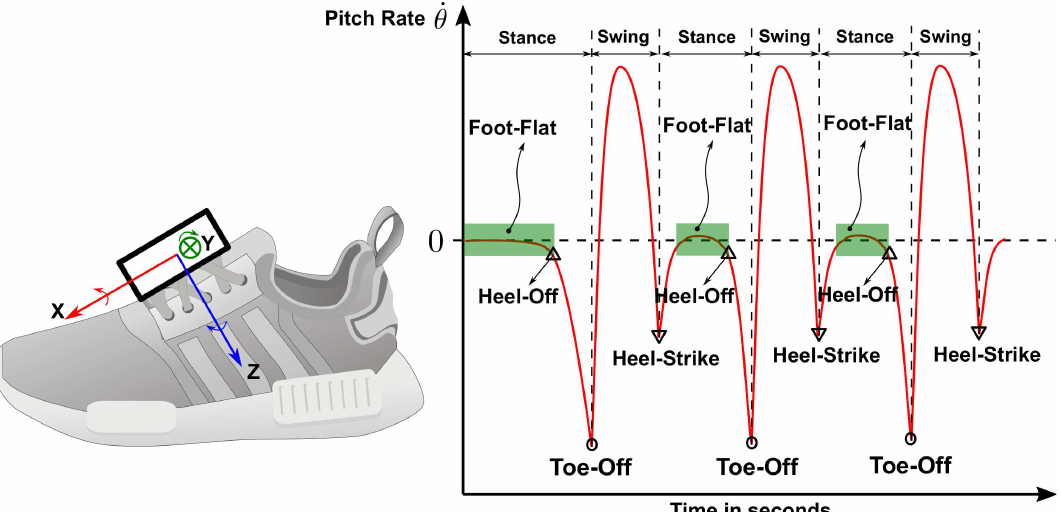
Figure 5. Foot-mounted sensor and its sagittal angular rate